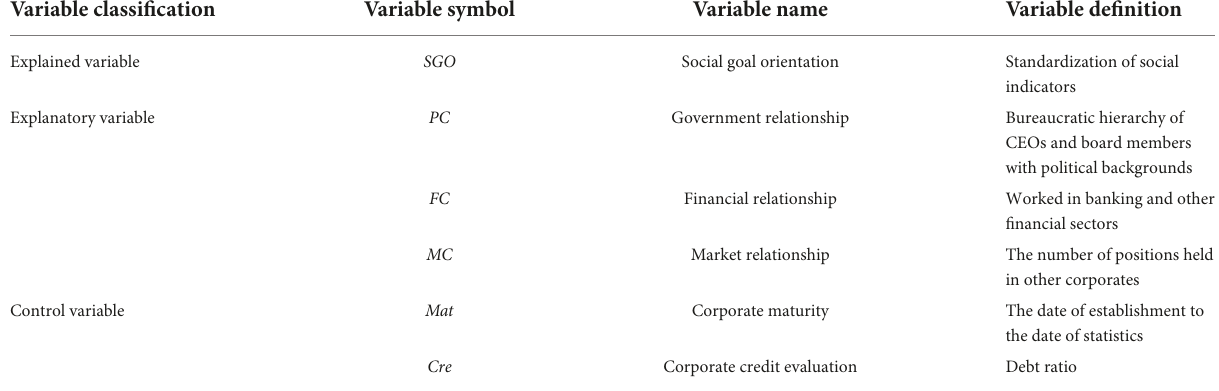
TABLE 1 Variable definitions.